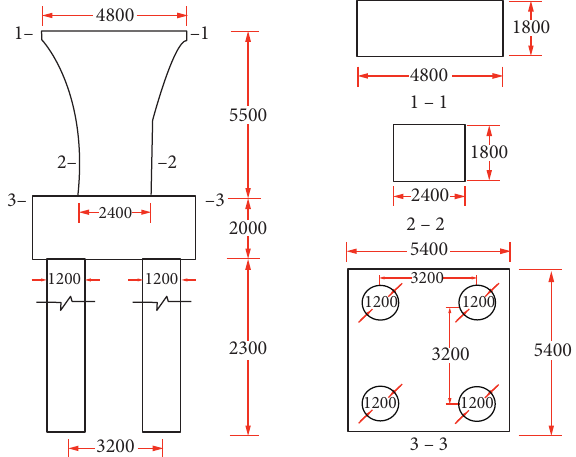
Figure 3: Dimension of the tested pier-cap-pile system (unit: